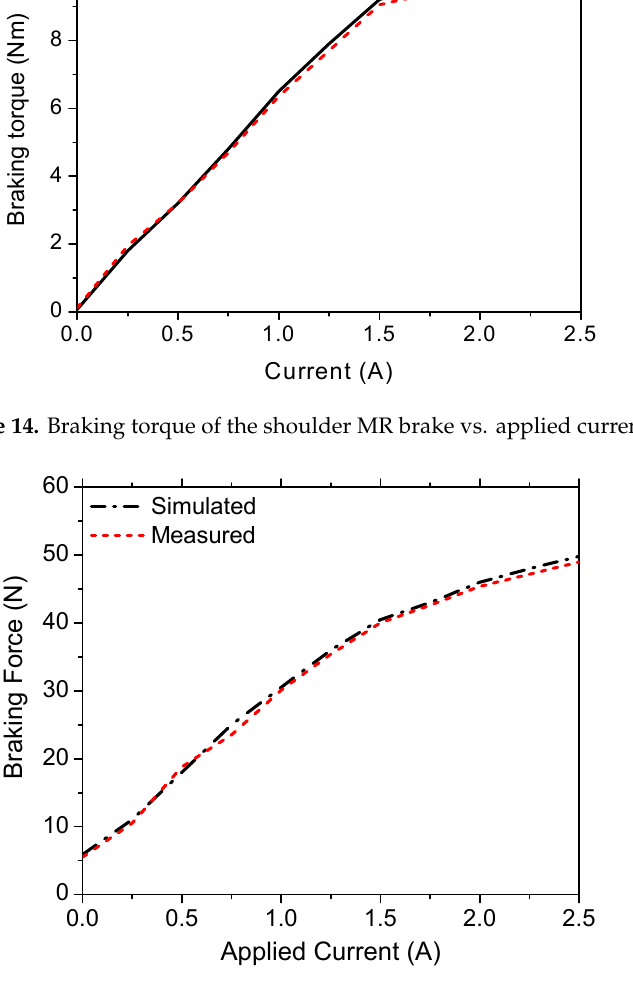
Figure 15. Braking force of the linear MR brake vs. applied current.